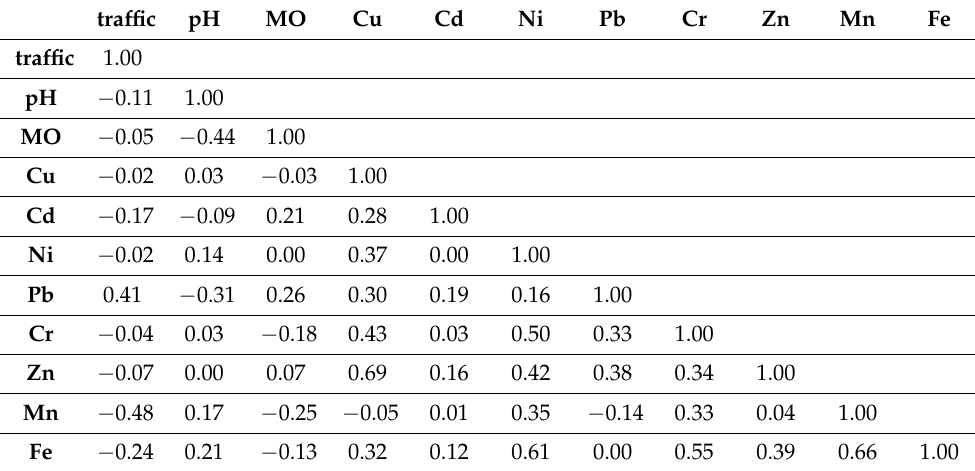
Table 4. Spearman correlations between heavy metal concentrations and soil